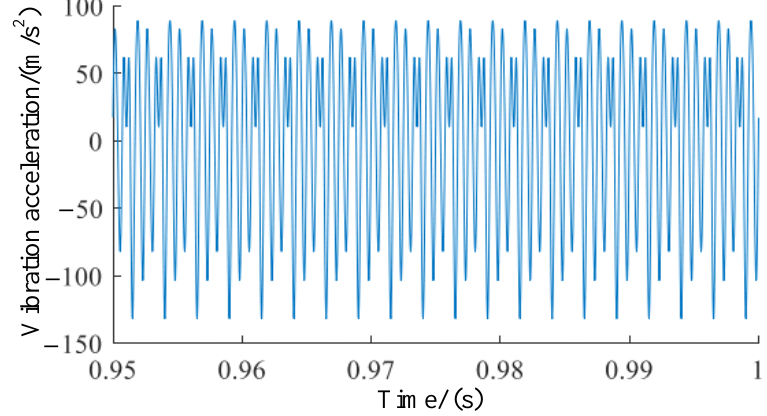
Figure 8. Time domain variation results of simulation vibration.